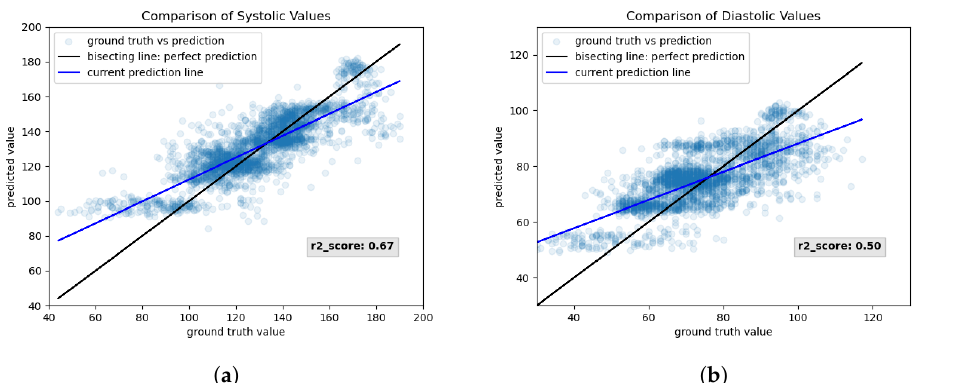
Figure 24. Results of training neural network with 25 input nodes, two hidden layers with 45 and 15 nodes, respectively, and 2 output nodes. Used correlation threshold for filtering: 0.9. Regularization: None. ( a ) Scatter plot of systolic values. ( b ) Scatter plot of diastolic